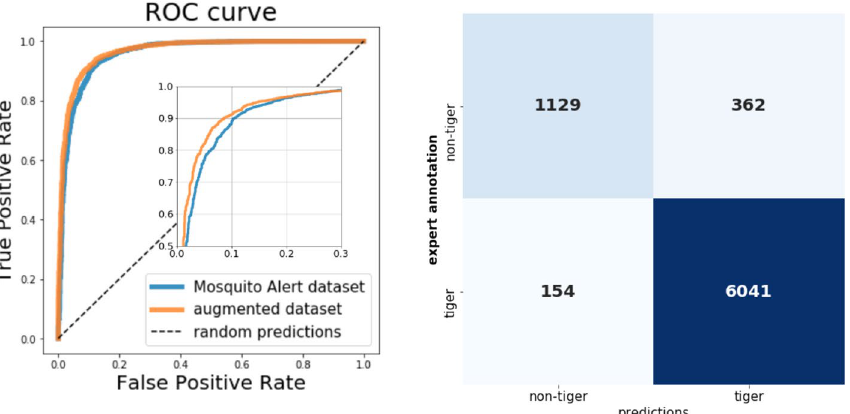
Figure 3. Left: ROC curve calculated on the prediction of the 7686 images in the Mosquito Alert dataset with yearly cross-validation. The blue line shows the case when only the Mosquito Alert dataset was used for training, the orange when the training dataset was balanced out with the addition of non-tiger mosquito insect images from the IP102 dataset. Also a zoom into the part of the ROC curve, where the two methods differ the most is highlighted. Right: the confusion matrix was calculated on the same predictions when only the Mosquito Alert dataset was used for training. For both, a positive label means tiger mosquito is present.